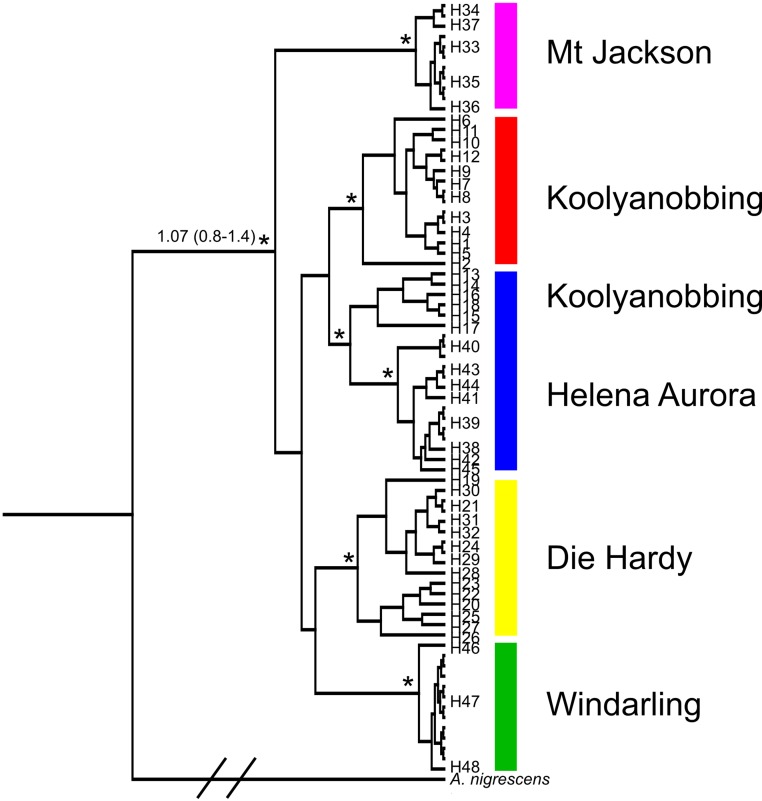
Bayesian cladogram of 75 Atelomastix bamfordi individuals based on combined CO1 and 16 S mtDNA data.Clades are designated separate colours as per Fig. 1. Numbers on terminals indicate haplotype number. The * denotes major nodes with high support (posterior probability>0.85) and the numbered node indicates divergence estimate in millions of years with confidence intervals in brackets. NB the A. nigrescens branch has been truncated (//) for viewing purposes.